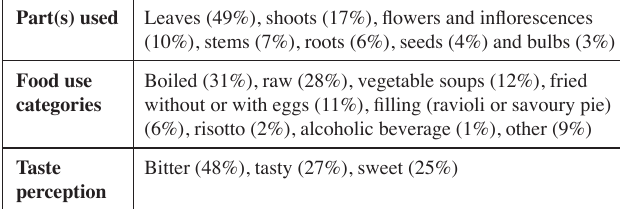
Tab. 2: EWPs studied: percentages of parts used, food use categories and taste perception. Part(s)